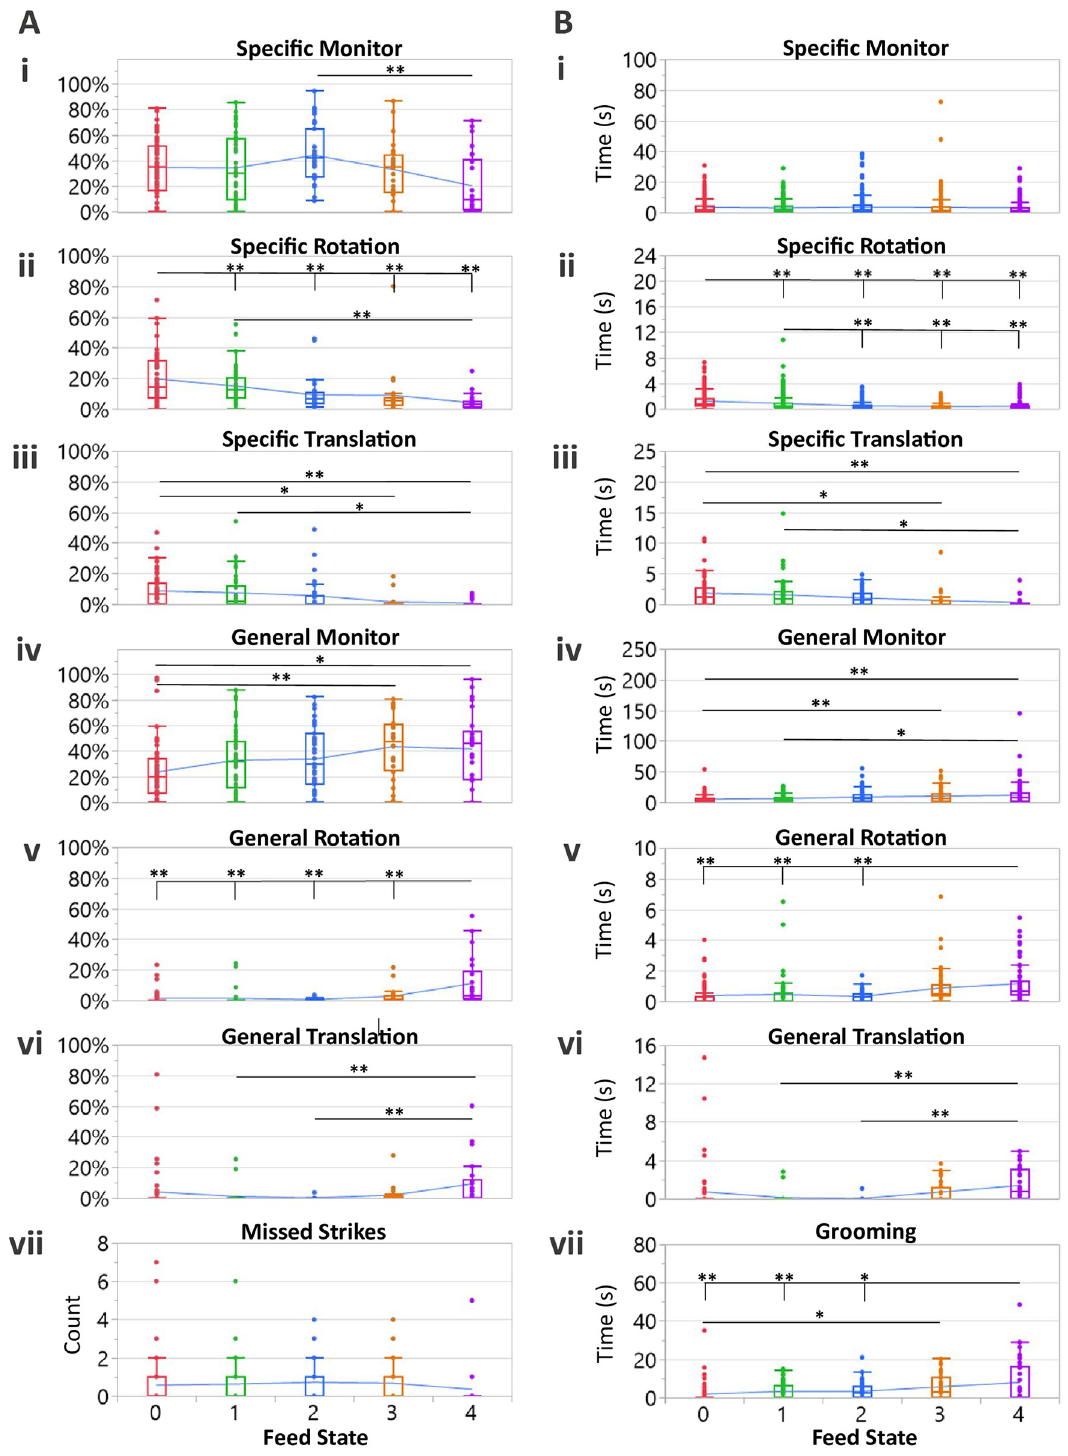
Fig 3. Behavioral probability and bout time analyses across all feeding states. (A) Probability plots for hunting behaviors exhibited by feed state. (Ai) Specific monitoring shows a slight increase in the 2-fed animals with a statistical difference relative to the 4-fed state (ANOVA: p = 0.0054). Decreasing probabilities of both specific rotation (Aii) and translation (Aiii) as satiety increases (ANOVA: p < 0.0001 and p = 0.0018, respectively). (Aiv) Number of missed strikes per subsequence across feeding states. Missed strikes showed a decrease for the 4-fed state (non-statistical trend; ANOVA: p = 0.78). Trends show increased probability of both general